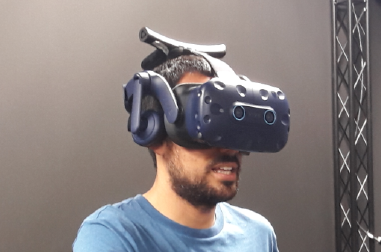
Figure 1. Example of a subject using the HTC Vive Pro Eye for the development of the experiment.